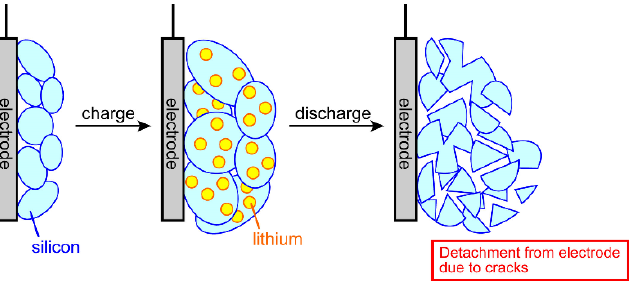
Figure 20. Collapse, pulverization, and detachment of silicon due to repeated charging and discharging.